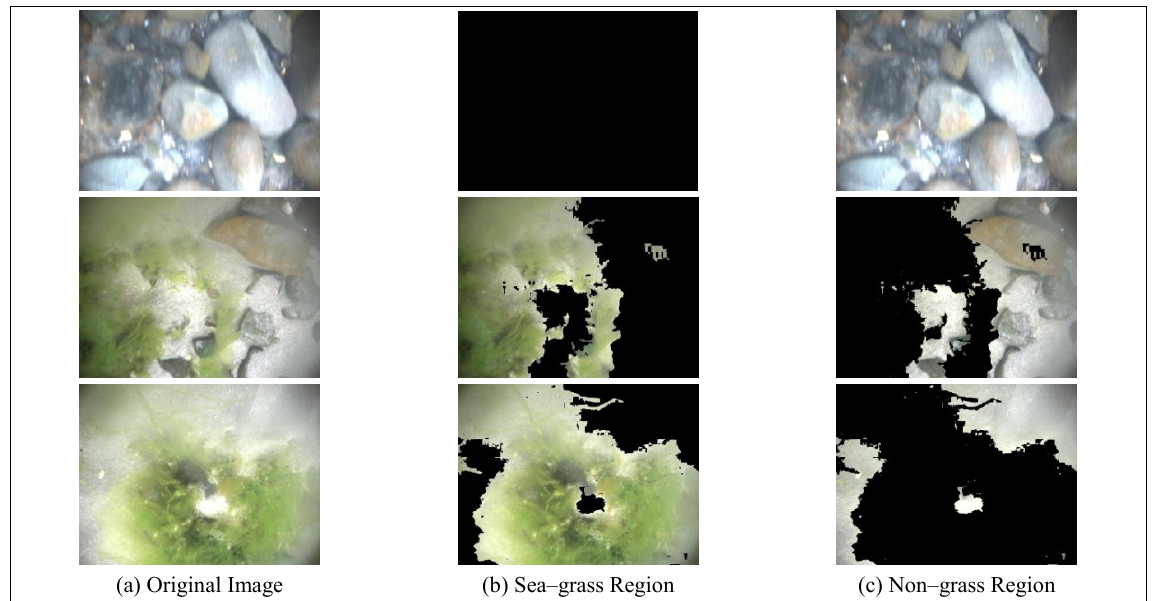
Fig. 2. Grass region extraction outcomes from seabed